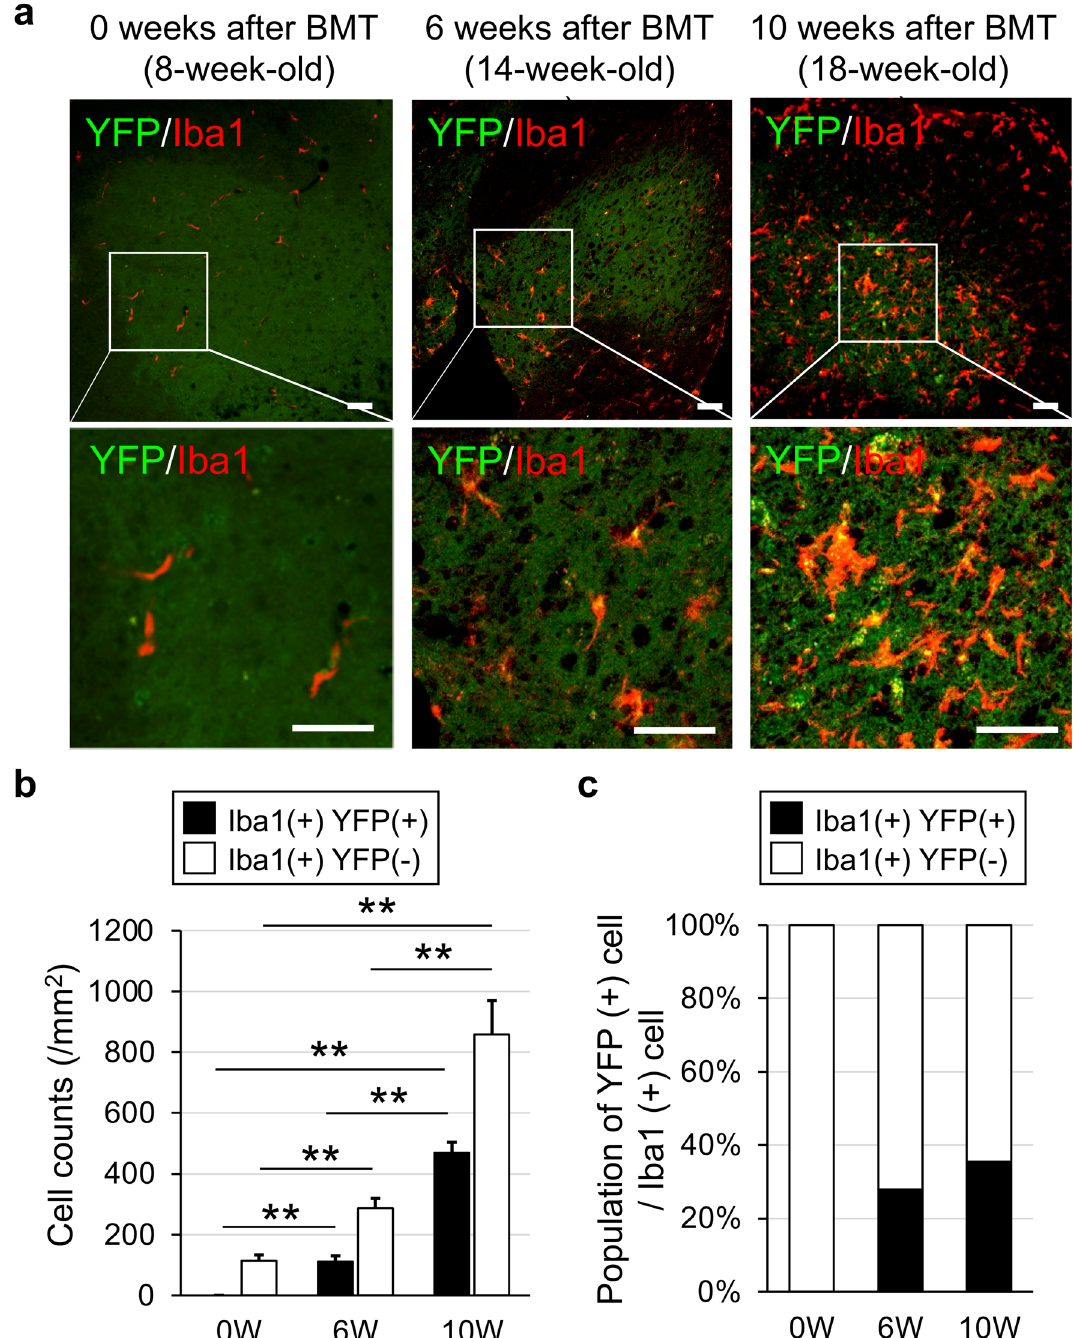
Figure 4. Accumulation of microglia expressing YFP and quantitative analysis of YFP signals in the spinal cord of SOD1(G93A) mice after transplantation. ( a ) YFP (green) and Iba1 (red) signals in ventral horn sections of the spinal cord at the lumbar level in SOD1(G93A) mice at 0 weeks (left panels, 8-week-old), 6 weeks (middle panels, 14-week-old) and 10 weeks (right panels, 18-week-old) after bone marrow transplantation with gene transduction by LV-CD68-YFP. Upper panels show low magnification images of spinal cords and lower panels show a high magnification image of the square in the upper panel of the same column. Scale bar = 50 µm. ( b ) Number of Iba1 and YFP positive cells (Iba1 + YFP +) and Iba1 positive and YFP negative cells (Iba1 + YFP −) in microglia of the spinal cord of SOD1(G93A) mice at 0, 6, and 10 weeks after bone marrow transplantation with gene transduction by LV-CD68-YFP (n = 5, each group). ( c ) Population of YFP positive cells in Iba1 positive cells in microglia of the spinal cord of SOD1(G93A) mice at 0, 6, and 10 weeks after bone marrow transplantation with gene transduction by LV-CD68-YFP (n = 5, each group). Error bars represent the mean + SD. **p <